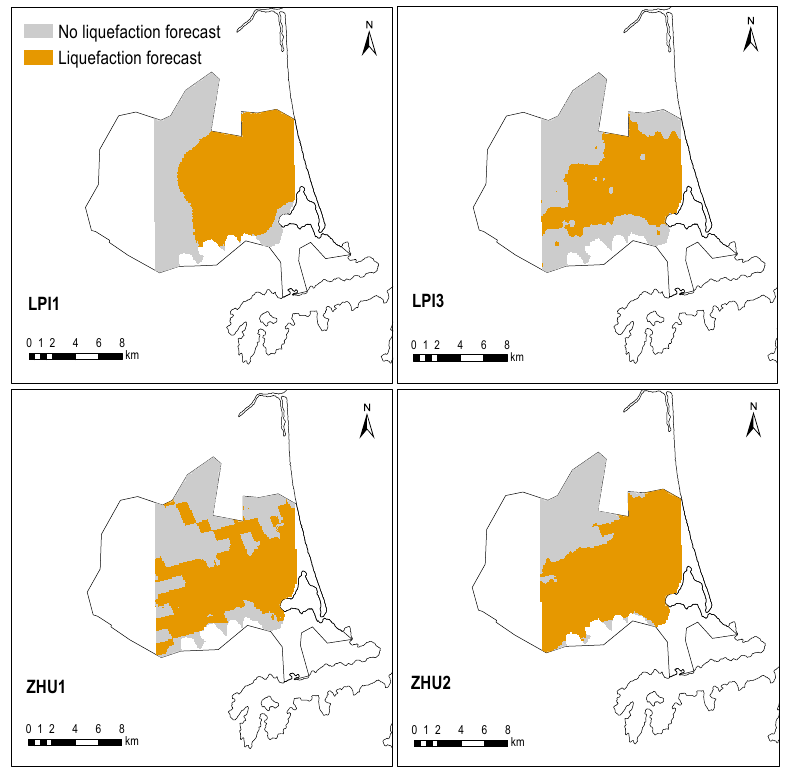
Figure 7. Maps of liquefaction forecasts from selected models for the Christchurch earthquake. Unshaded areas are where no forecast was made due to unavailability of input data. Refer to Table 4 for descriptions corresponding to model